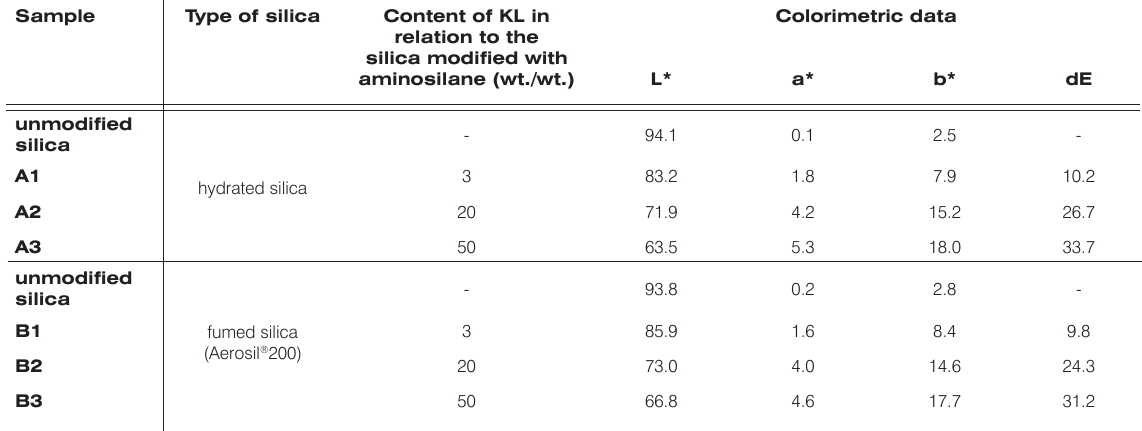
Table 2. Colorimetric data for silicas and silica/lignin products obtained from hydrated (A1–A3) and fumed (B1–B3) silicas. Sample Type of silica Content of KL in relation to the silica modified with aminosilane